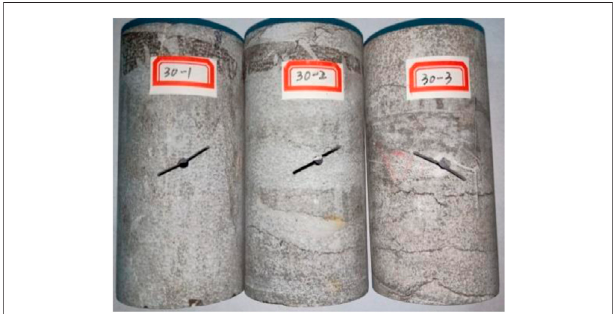
FIGURE 1 | Dry rock samples.